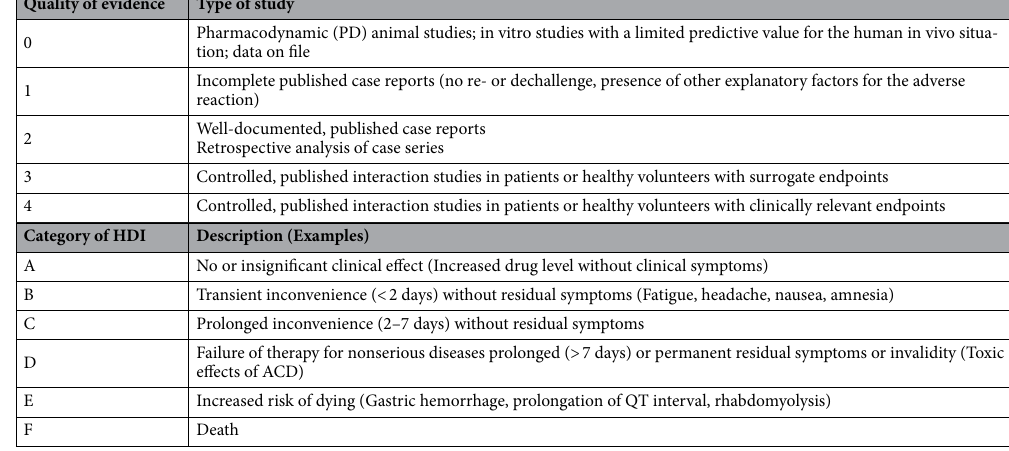
Table 1. Scoring of clinical risk of HDI adapted from De Smet’s algorithm 6 based on an alpha-numeric